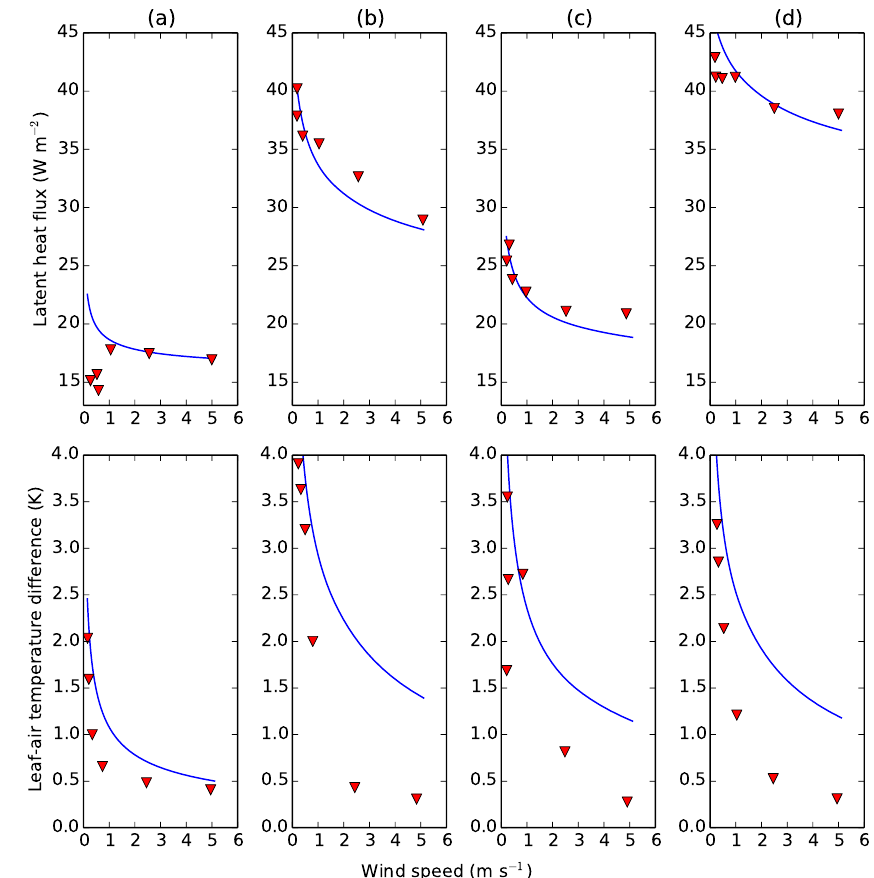
Figure 3. Modelled latent heat fluxes and leaf temperatures compared to observations by Dixon and Grace (1984). Symbols represent data points extracted from Fig. 3 in Dixon and Grace (1984), converted to units used in the present paper. Absorbed shortwave radiation ( R s ) and stomatal conductance ( g sv ) were adapted within the ranges quoted in the paper to best reproduce the data. (a) P. sylvestris ( R s = 200Wm − 2 , g sv = 0 . 00125ms − 1 ); (b) S. aucuparia ( R s = 200Wm − 2 , g sv = 0 . 00182ms − 1 ); (c) Q. robur ( R s = 200Wm − 2 , g sv = 0 . 00125ms − 1 ); (d) F. sylvatica ( R s = 170Wm − 2 , g sv = 0 . 0025ms − 1